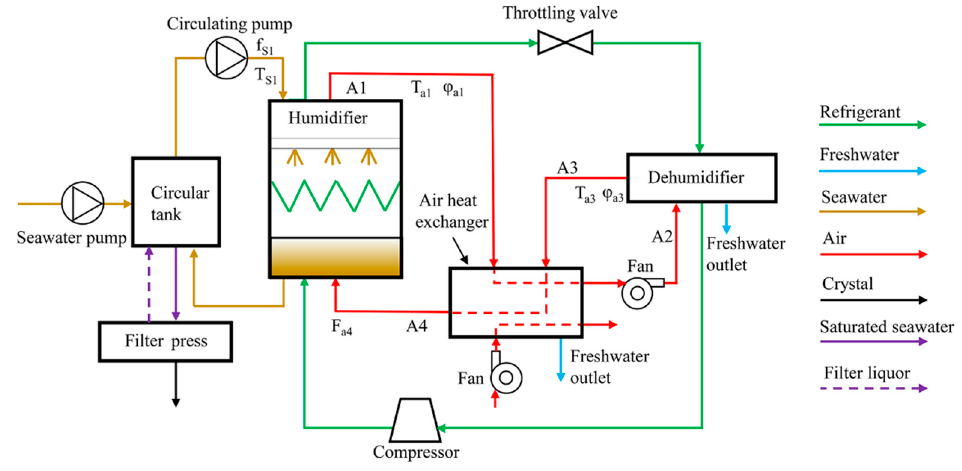
Figure 1. Schematic drawing of experimental set-up.